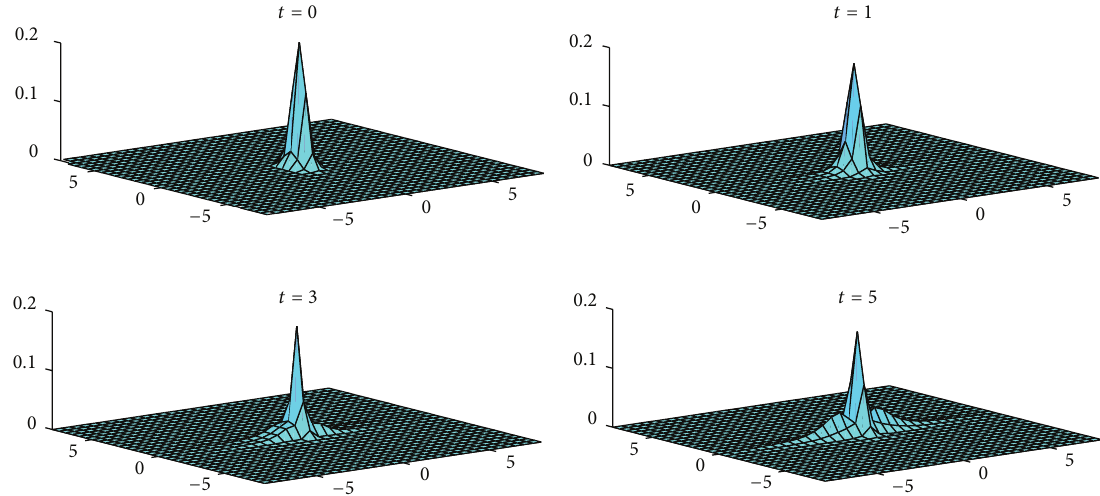
Figure 2: The wave function evolution according to time. Surface plots for |𝜑 1 (𝑥,0,𝑧, 𝑡)| 2 at different times.